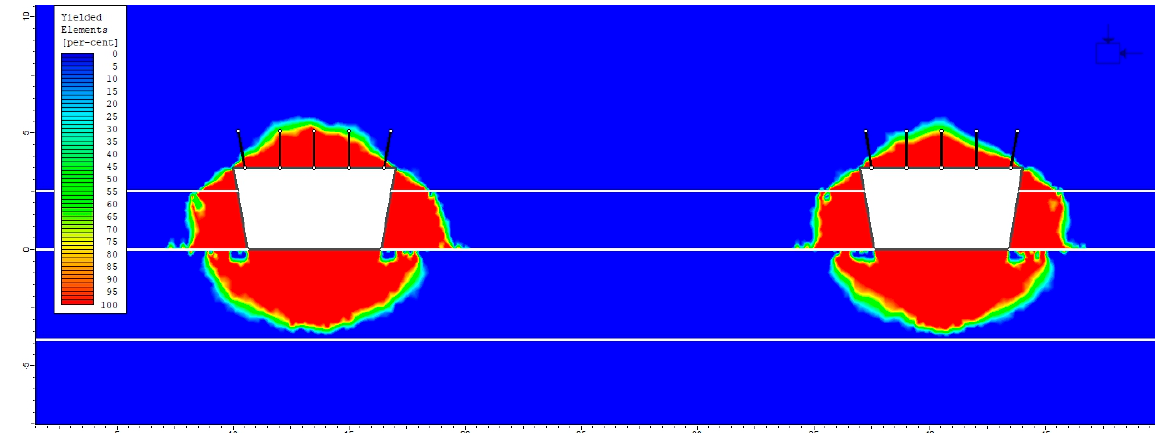
Figure 7. Yielded element area around heading – 3 and heading – 4, load variant – 1.